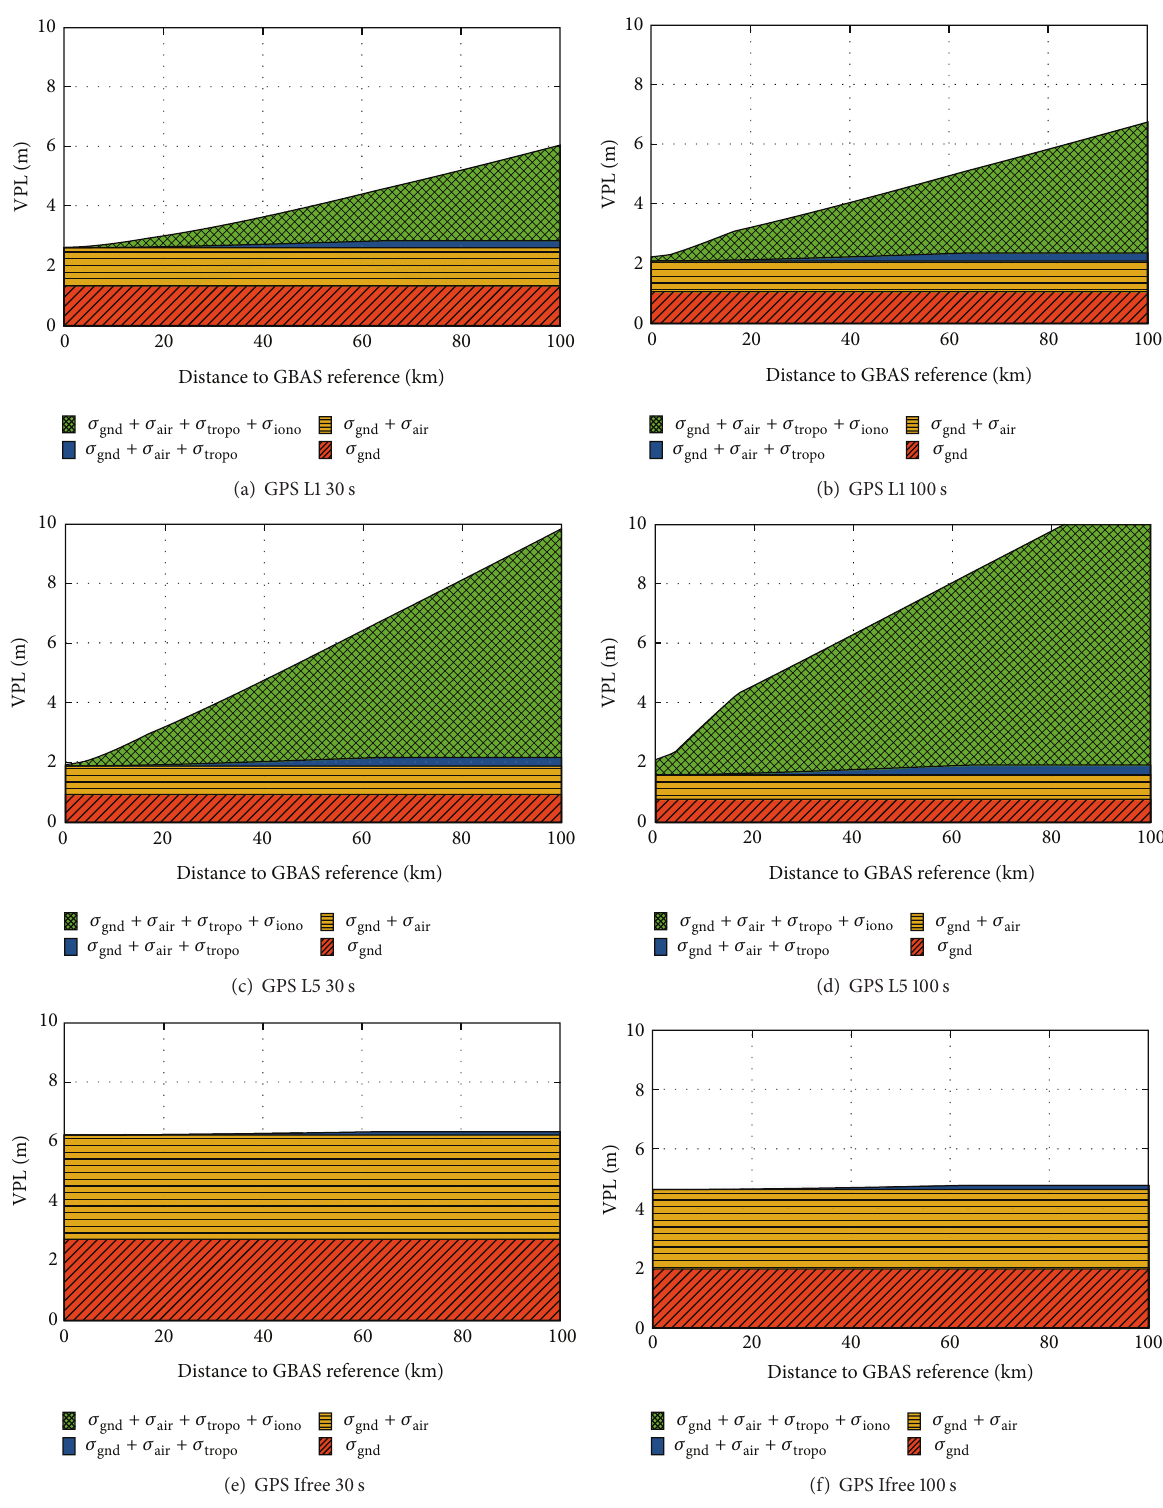
Figure 12: H0 protection level contributions of different 𝜎 -terms over distance to the GBAS